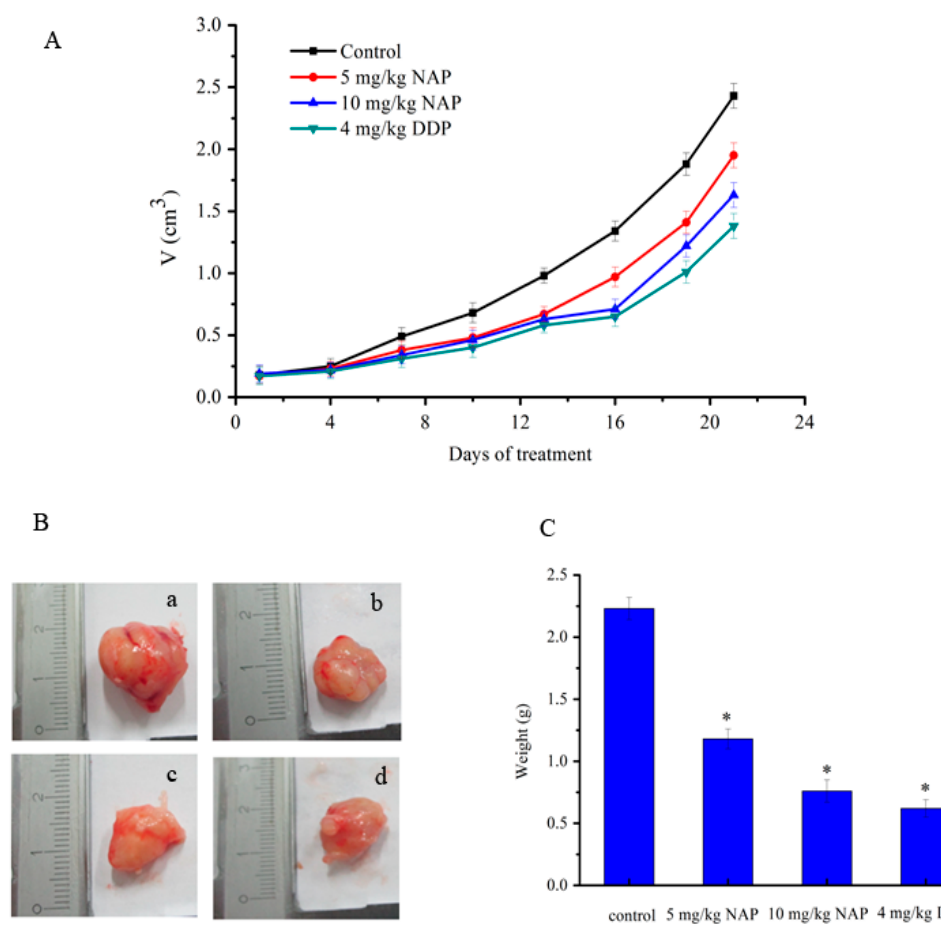
Figure 8. Inhibition of H1299 lung tumor growth by the NAP. ( A ) To identify the effect of NAP on H1299 lung tumor growth, nude mice were treated with 0, 5 and 10 mg/kg NAP for 21 days ( n = 4). The positive control was treated with 4 mg/kg DDP; ( B ) Pictures of the final tumors. (a) Nude mice treated with 0 mg/kg NAP. (b) Nude mice treated with 5 mg/kg NAP. (c) Nude mice treated with 10 mg/kg NAP. (d) Nude mice treated with 4 mg/kg DDP; ( C ) The graph shows the final weight of the tumor. * p < 0.05 vs. control.